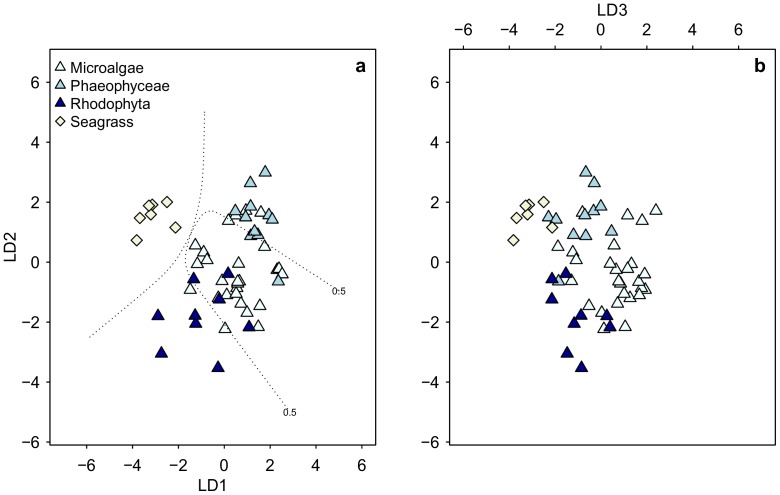
Linear discriminant function analysis with the δ13CEAAvalues (Ile, Leu, Lys, Phe, Val) from the three algal groups.It separates all seagrass samples from the three algal groups. The majority of the algal samples classified correctly within their own groups (Table S7). The dotted lines represent confidence ranges at P = 0.5; confidence ranges are only displayed in the left figure (a) because the third linear discriminant in right figure (b) only explained 14%.